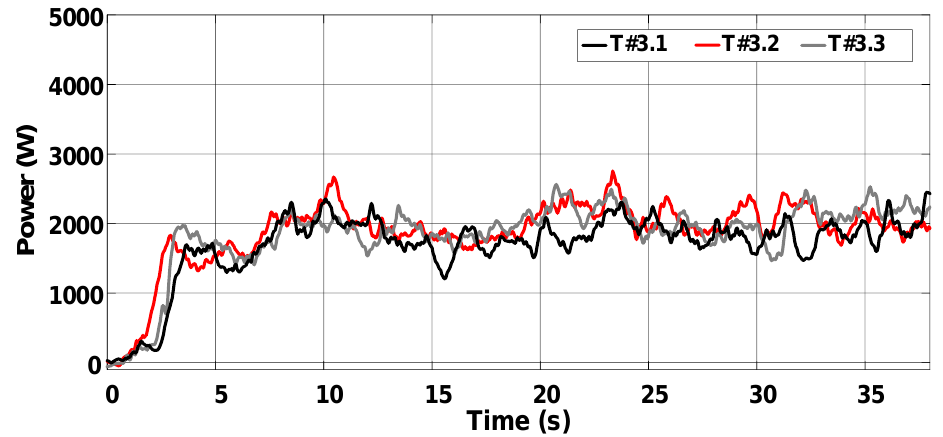
Figure 29. Power consumption during the trial sessions carried out on firm soil with the slip automatically adjusted by the proposed control scheme.